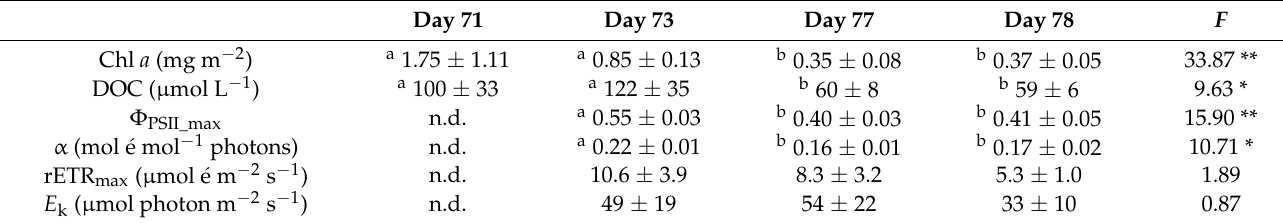
Table 1. Mean ± SD ( n = 3) for Chl a , DOC (dissolved organic carbon), Φ PSII_max , α , rETR max , and E k for the lower 30 mm of the ice before (Days 71 and 73) and after (Days 77 and 79) snowmelt on the fjord. F values from repeated-measures ANOVA shown with significant tests identified as p < 0.05 *, p < 0.01 **. Different letter superscripts within rows identify means that differ significantly where ANOVA is significant. Chl a and DOC were sampled on all four occasions; photobiology (Phyto-PAM) was not performed on Day 71 (n.d. = not determined). Degrees of freedom are 3, 9 for Chl a and DOC, and